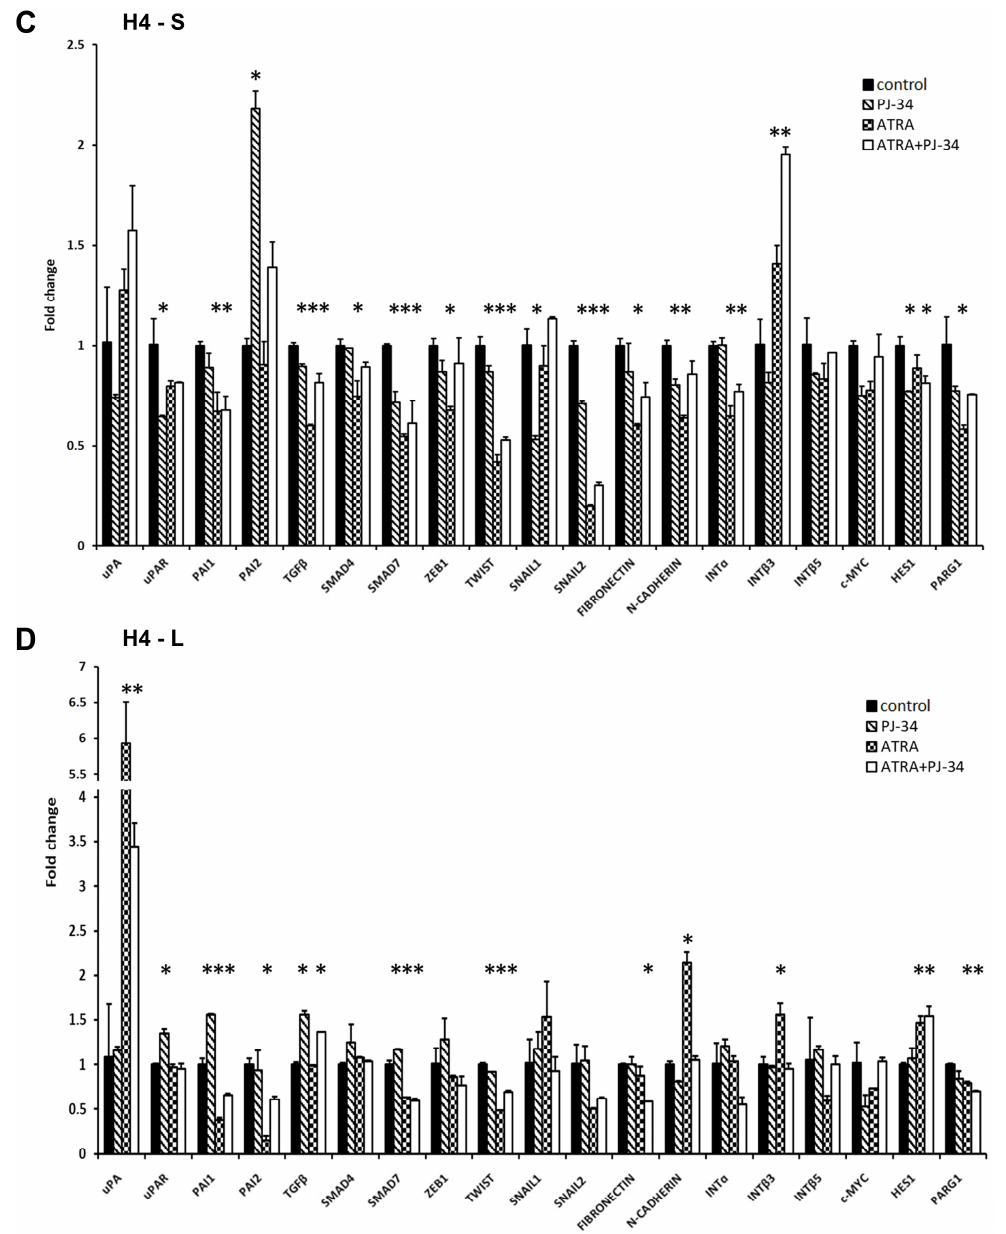
Figure 4. qRT-PCR analysis of the expression of genes involved in the uPA system and EMT in A1235 and H4 cells after 1 and 9 days of ATRA and PJ-34 treatment: Cells were treated with 10 µM ATRA and 20 µM PJ-34 and their combination every second day. RNA was isolated from cells treated for 1 and 9 days, and cDNA was produced and examined by qRT-PCR. Relative gene expression level was obtained by normalization of its values with those of hypoxanthine-guanine phosphoribosyltransferase ( HPRT ) and is presented as a fold change in comparison with untreated control cell values. ( A ) A1235 cells treated for 1 day; ( B ) A1235 cells treated for 9 days; ( C ) H4 cells treated for 1 day; and ( D ) H4 cells treated for 9 days. S: 1-day treatment; L: prolonged treatment; PJ-34: cells treated with PARP inhibitor; ATRA: cells treated with ATRA; ATRA + PJ-34: cells treated with ATRA and the PARP inhibitor. Data are expressed as mean ± SD. * The mean values were significantly di ff erent from the control ( p < 0.05). Experiments with prolonged cell treatment were done at least two times, and representative results are